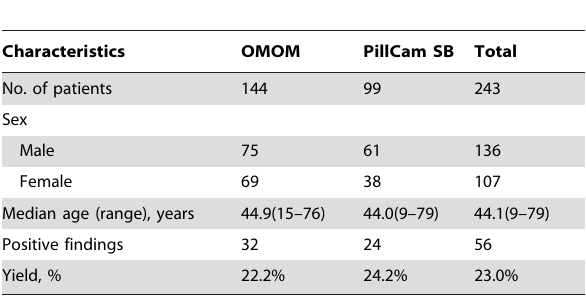
Figure 1. Ulcers and stenosis found by CE. Ulcers and stenosis in the upper part of the small intestine were found by CE in a 56-year-old woman with abdominal pain. The diagnosis of Crohn’s disease was confirmed both surgically and pathologically.